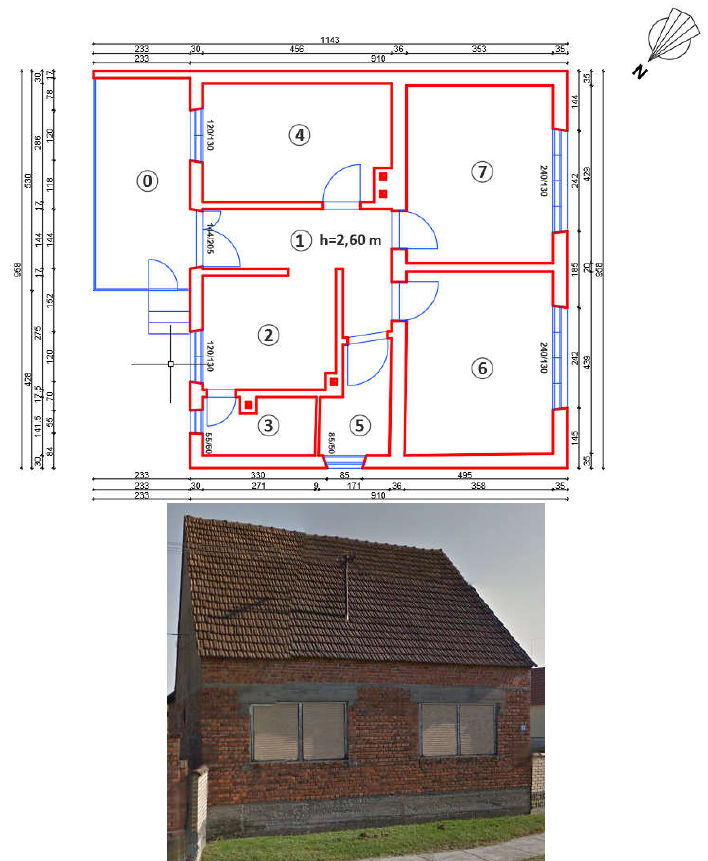
Figure 3. Layout of the ground floor and external view of the analyzed building.